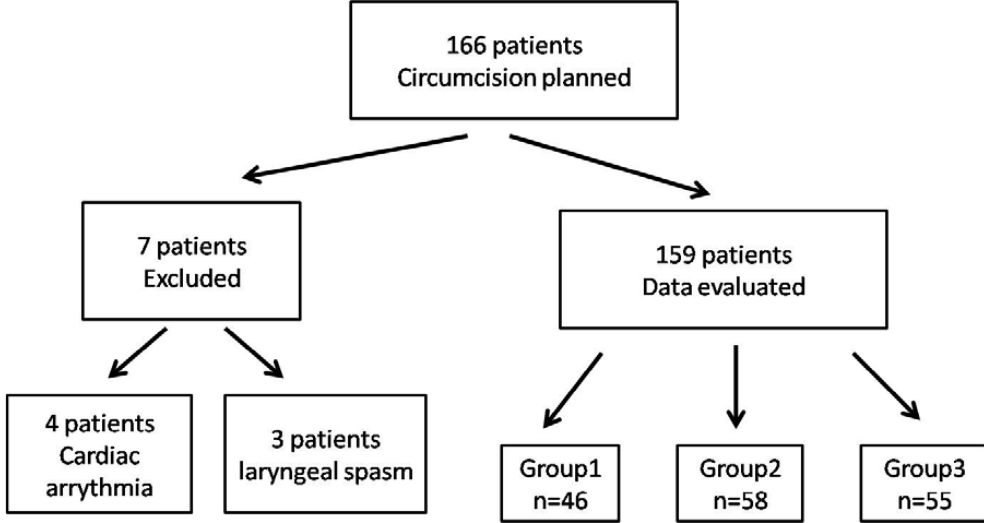
Figure 1 - Flow of